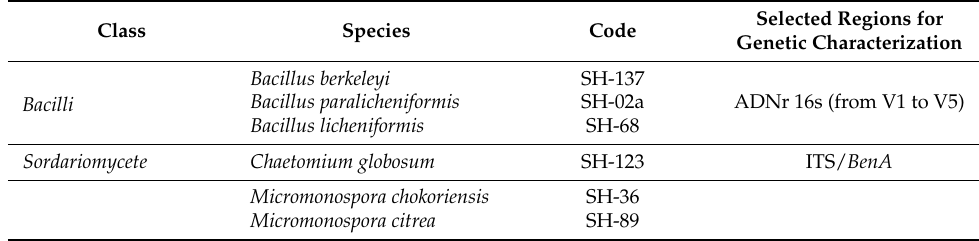
Table 1. Microbial strains isolated from Scopalina hapalia (ML-263) selected for the